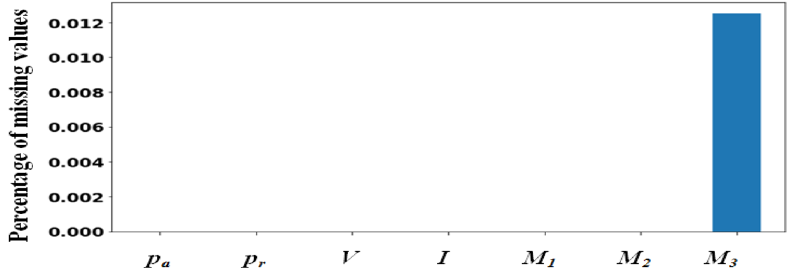
Figure 2: Percentage of missing values in the